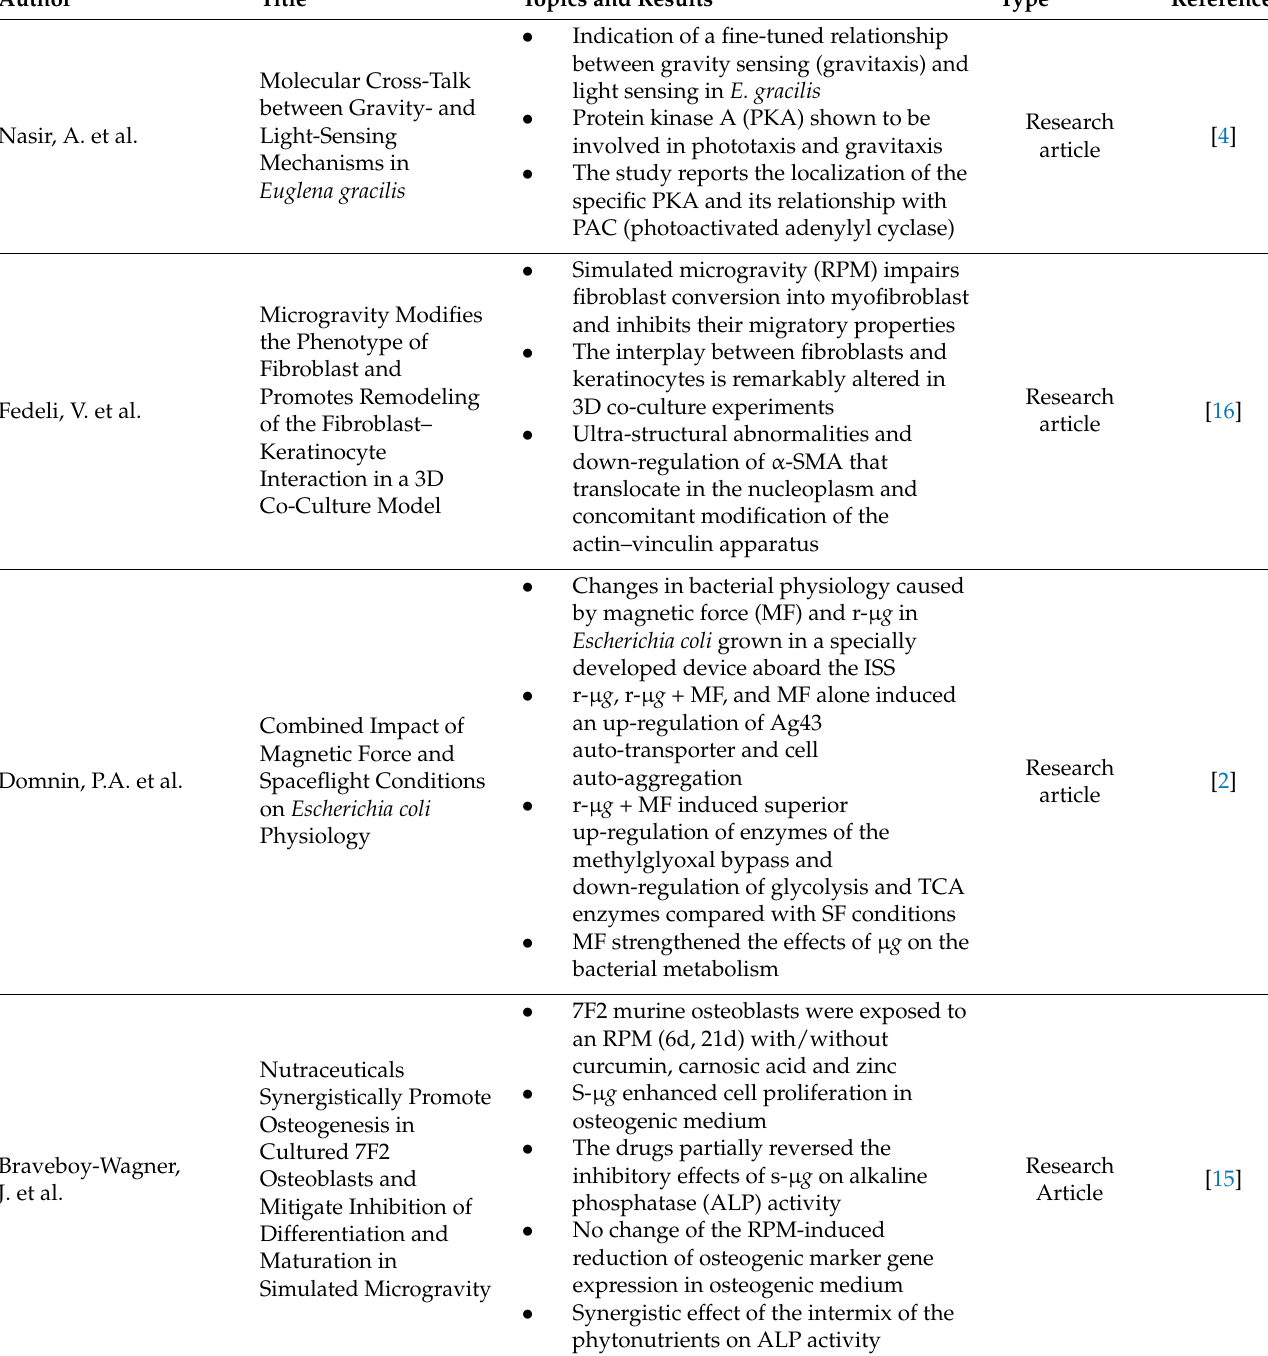
Table 1. Contributions to the Special Issue “Microgravity and Space